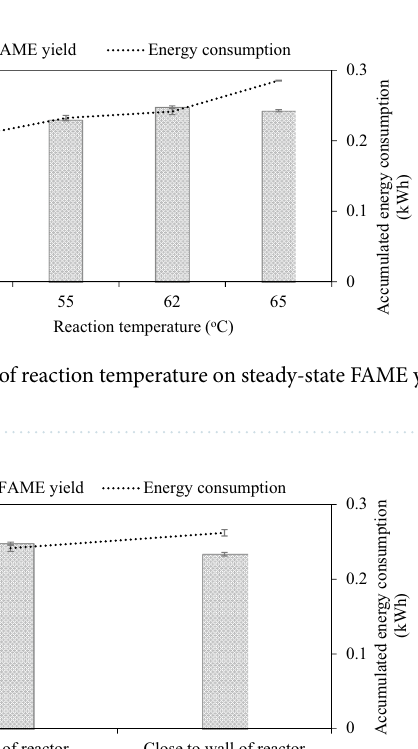
Figure 4. Effect of catalyst loading on steady-state FAME yield (refined palm oil, 2000 mL, 50 mL/min, 62–63 °C).